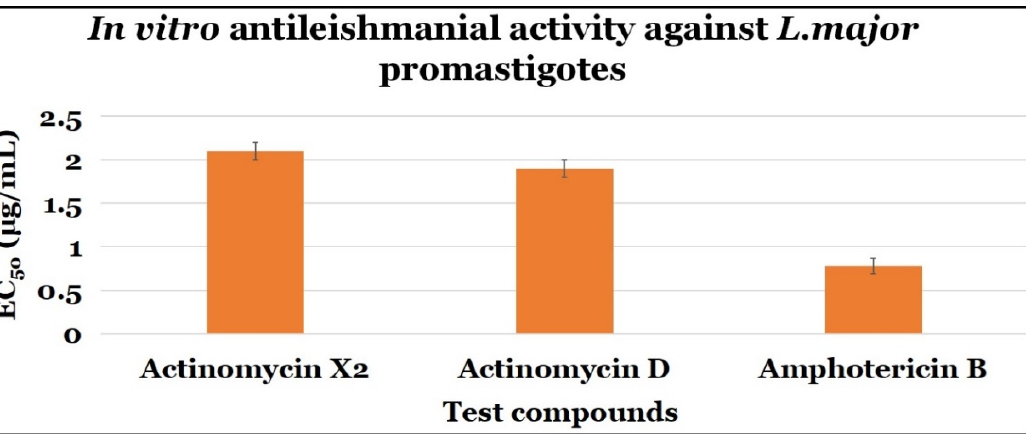
Figure 4. The anti-promastigotes activity of test compounds .